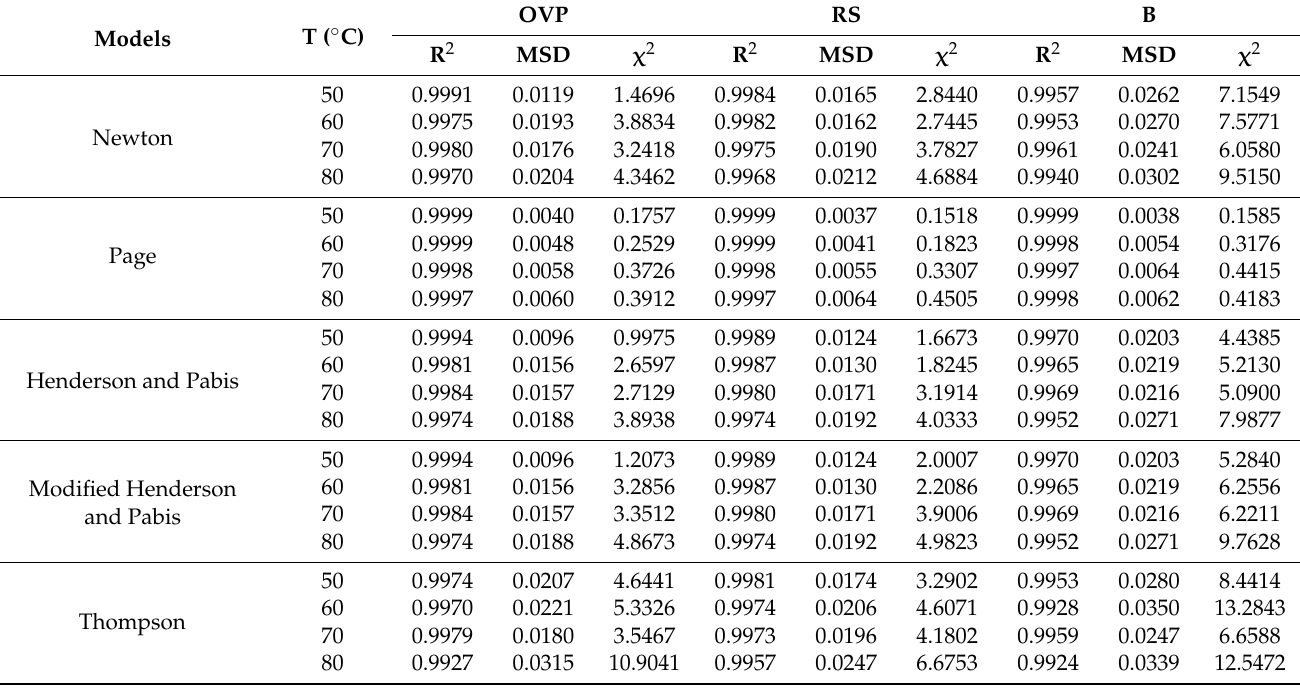
Table 2. Coefficients of determination (R 2 ), mean square deviations (MSD) and chi-squares ( χ 2 ) of the mathematical models adjusted to the drying kinetics data of the germinated seeds of faba beans (varieties OVP, RS, B), at temperatures of 50, 60, 70 and 80 ◦